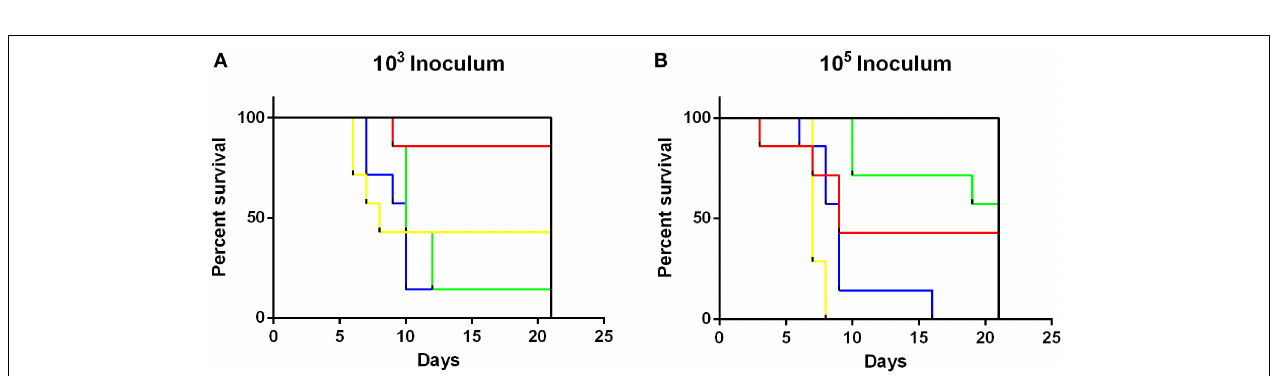
FIGURE 2 | Morbidity in mice infected with Salmonella Typhimurium definitive types. Clinical signs of infection appeared from day 2 with 10 3 CFU of individual serovars (A) . Peak morbidity in low dose animals ranged between